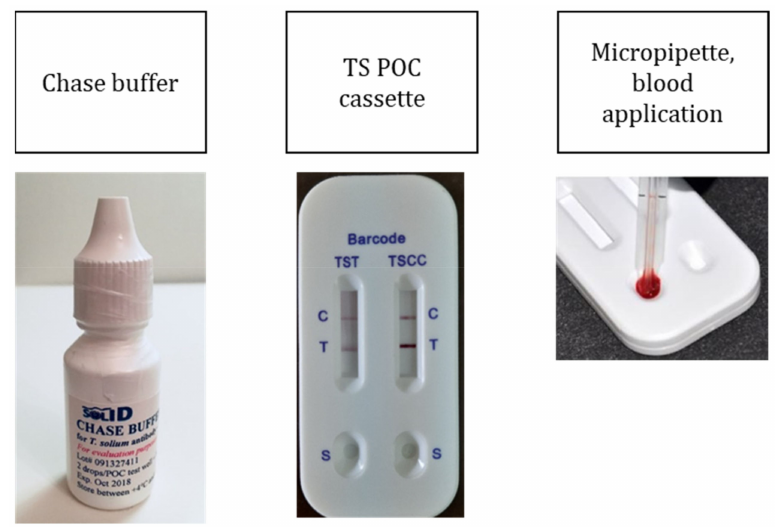
Figure 1. Taenia solium TS POC kit, chase buffer, cassette and